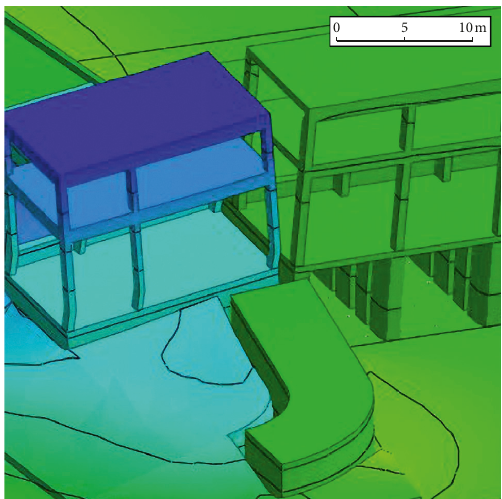
Figure 16: Gaps in a sluice engineering structure (offshore